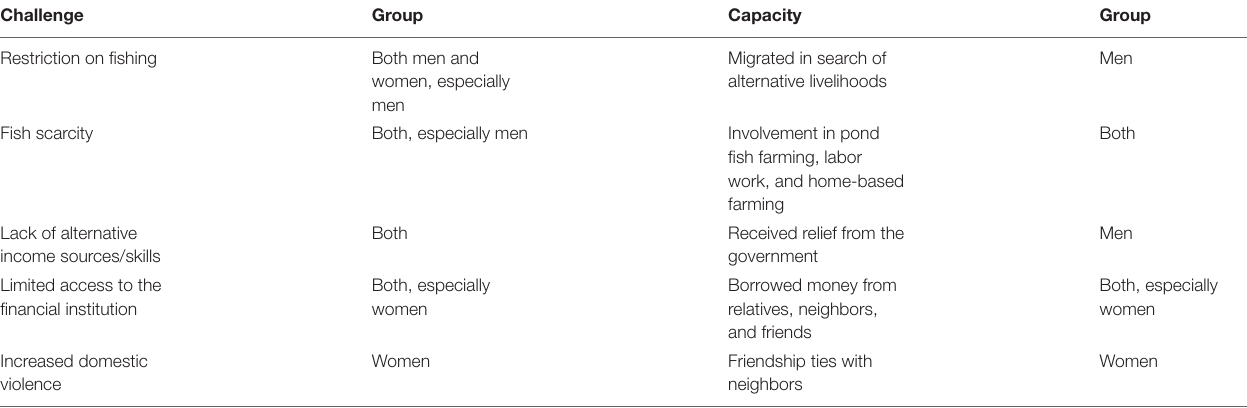
TABLE 3 | Challenges and capacities affecting individual resilience of the studied fishing communities of